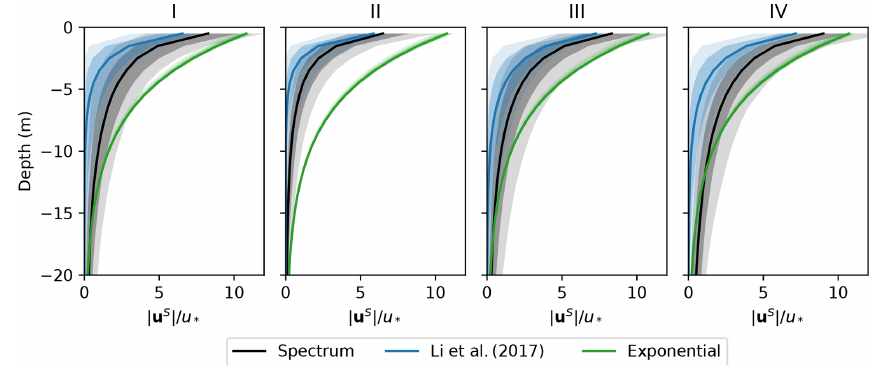
Figure 7. A comparison of the Stokes drift profiles estimated from the observed wave spectrum in black, “theory wave” approach of Li et al. (2017) in blue and an idealized exponential profile with La t = 0 . 3 and δ S = 5m in green during the four stages of a seasonal cycle at Ocean Station Papa. Stokes drift is normalized by the surface friction velocity u ∗ . The lines show the median, and the dark and light shadings enclose 50% (25th to 75th percentiles) and 80% (10th to 90th percentiles) occurrence during each